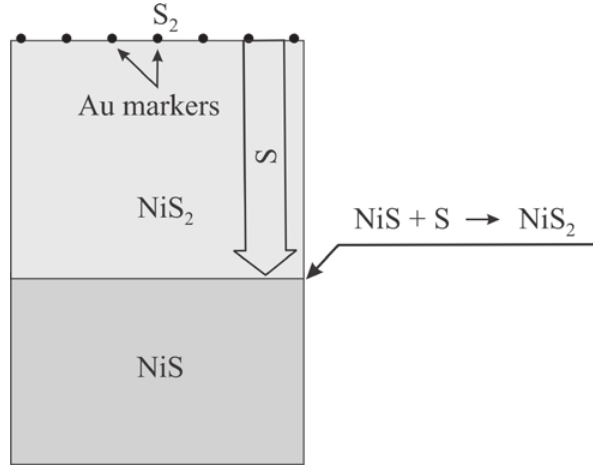
Fig. 6: Marker position in the NiS 2 layer, grown on the surface of NiS as a result of the inward diffusion of